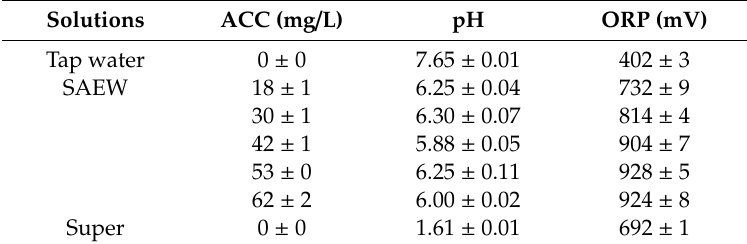
Table 3. Physicochemical properties of treatment